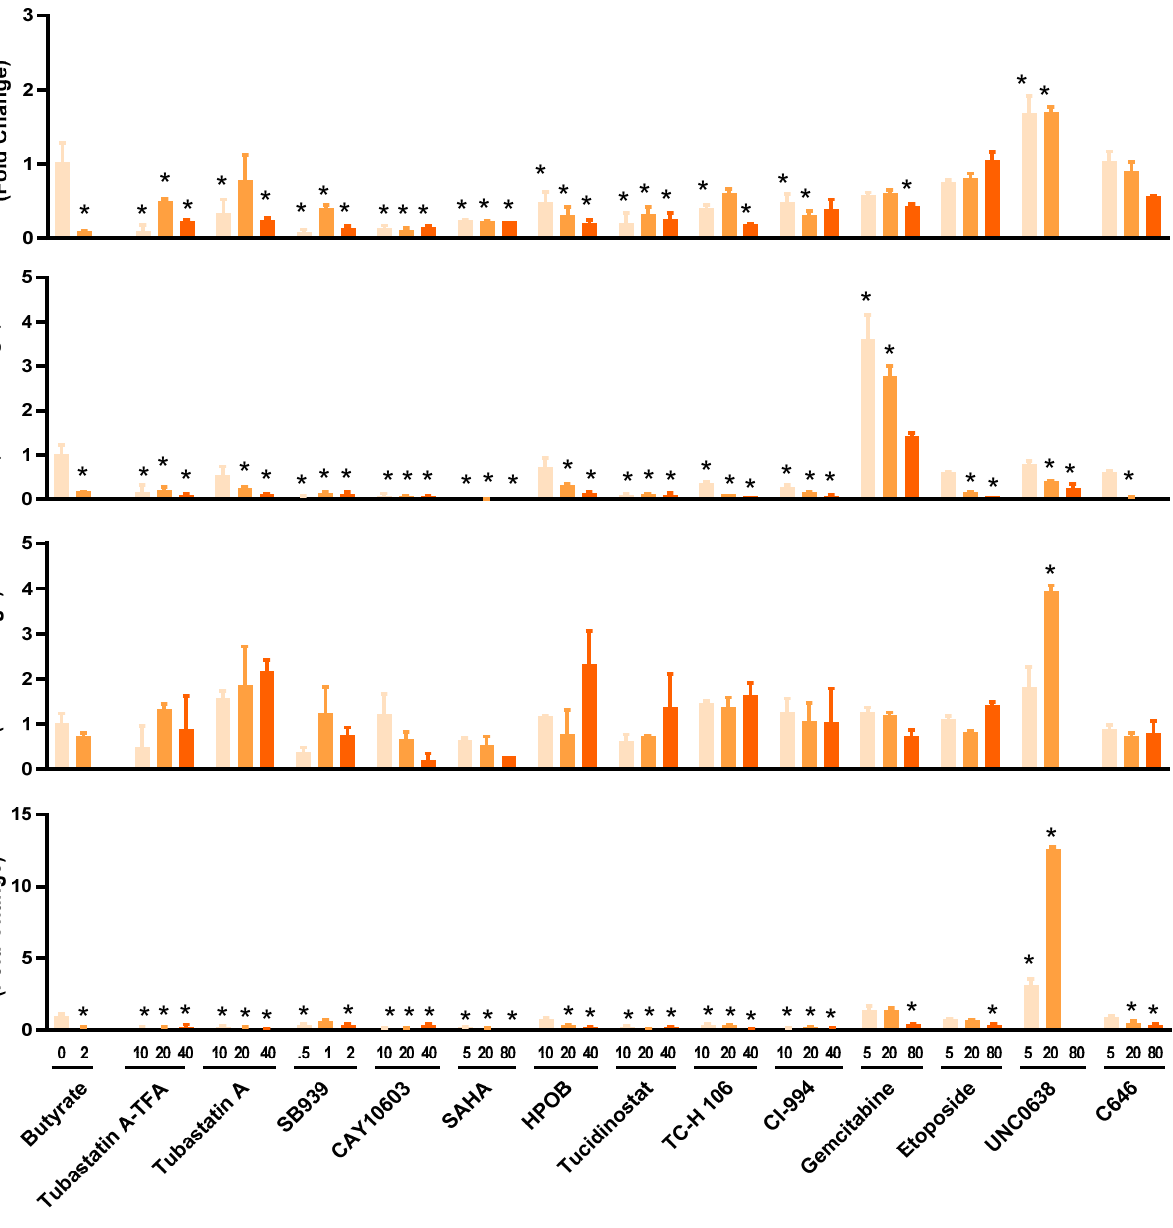
Figure 5. Differential regulation of representative genes involved in intestinal barrier function by selected epigenetic compounds. HT-29 cells were stimulated with or without indicated concentrations ( μ M) of each compound for 24 h, followed by RT-qPCR analysis of mRNA expression levels of the genes for claudin-1 ( CLDN1 ), claudin-2 ( CLDN2 ), tight junction protein 1 ( TJP1 ), and mucin 2 ( MUC2 ). Sodium butyrate (2 mM) was used as a positive control. The results are means ± SEM of 2–3 independent experiments. Statistical significance was determined by one-way ANOVA and post hoc Dunnett’s test. * p < 0.05 compared with the nonstimulated control.